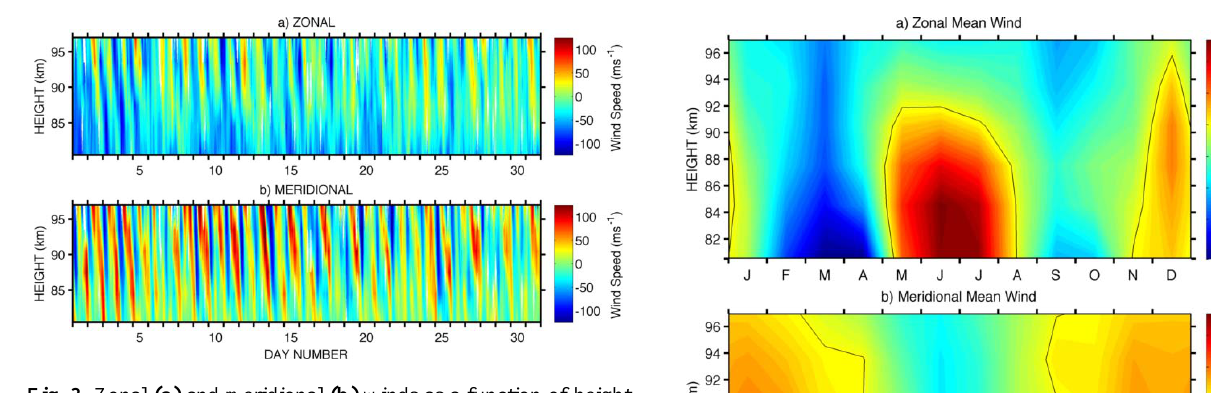
Fig. 3. Zonal (a) and meridional (b) winds as a function of height and time as recorded by the Ascension Island meteor radar in March 2009. The large-amplitude diurnal tide can clearly be seen in both wind components.